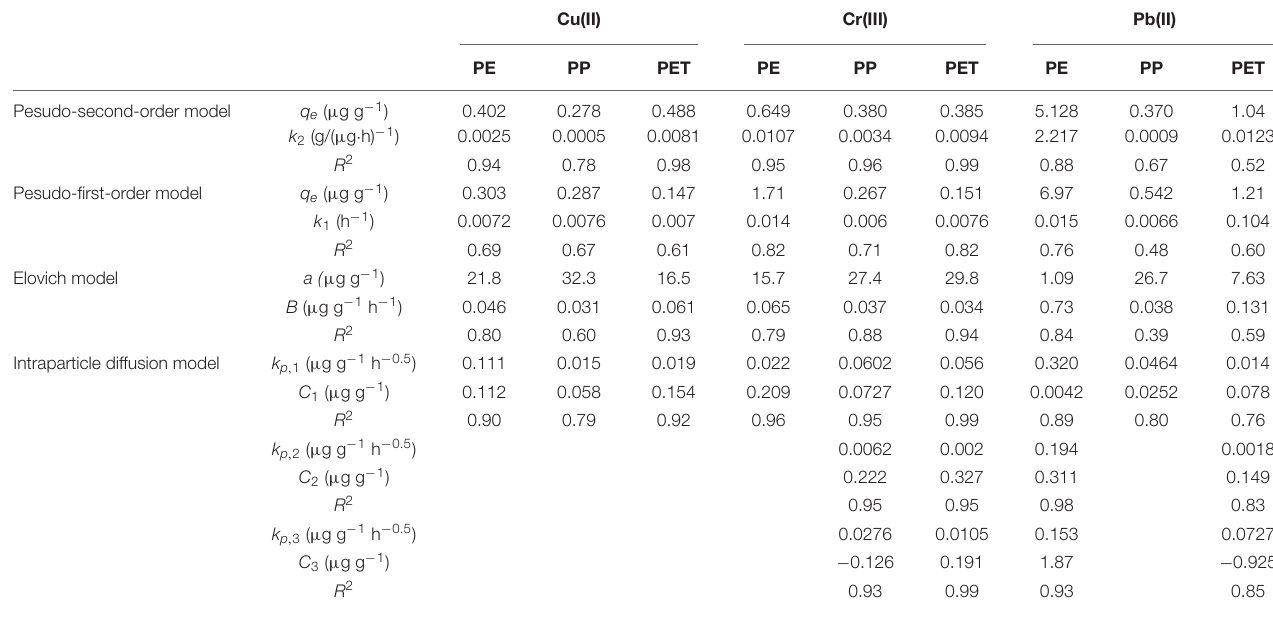
TABLE 1 | The fitting parameters of different models of Cu(II), Cr(III), and Pb(II) adsorbed onto PE, PP, and PET microplastics,